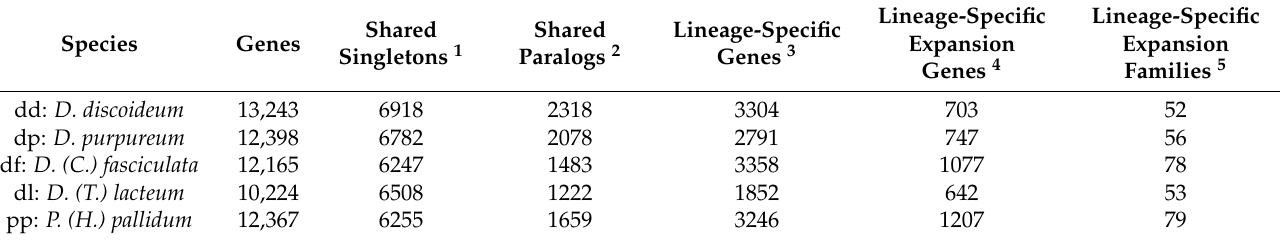
Table 1. Orthologs and paralogs across five dictyostelid genomes based on orthogroup membership and size.